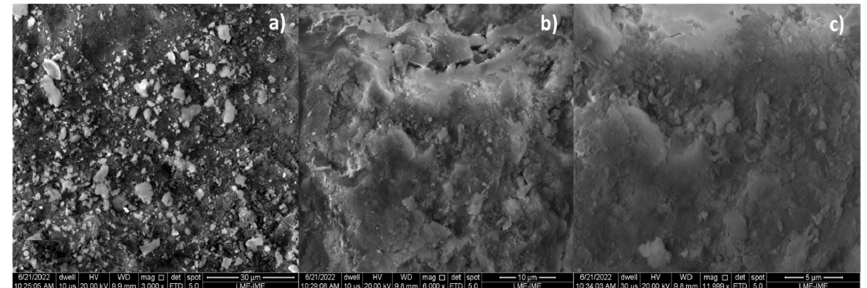
Figure 6. SEM of bio-char obtained by thermal catalytic cracking of (organic matter + paper) fraction of MHSW at 475 °C, 1.0 atmosphere, with 5.0% (wt.) Ca(OH) 2 [MAG: 5999× ( a ); MAG: 3000× ( b ); MAG: 11,999× ( c )].